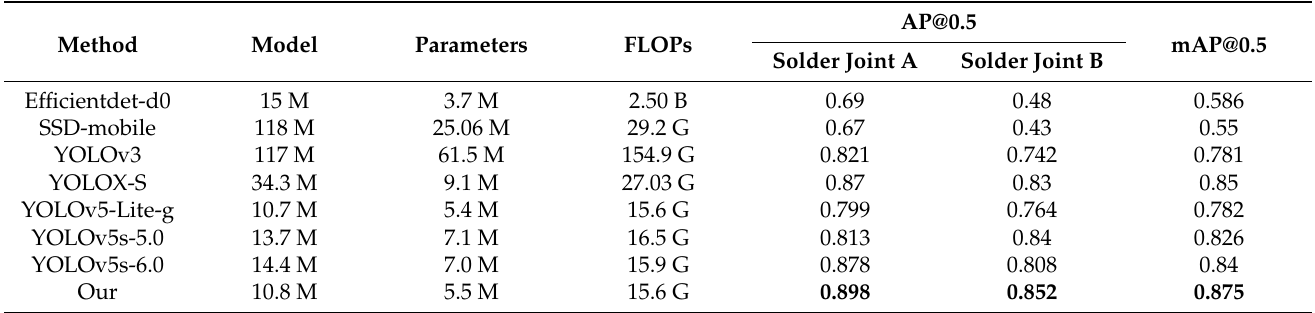
Table 1. Performance comparison of our method with mainstream target detection models on chip pad dataset.